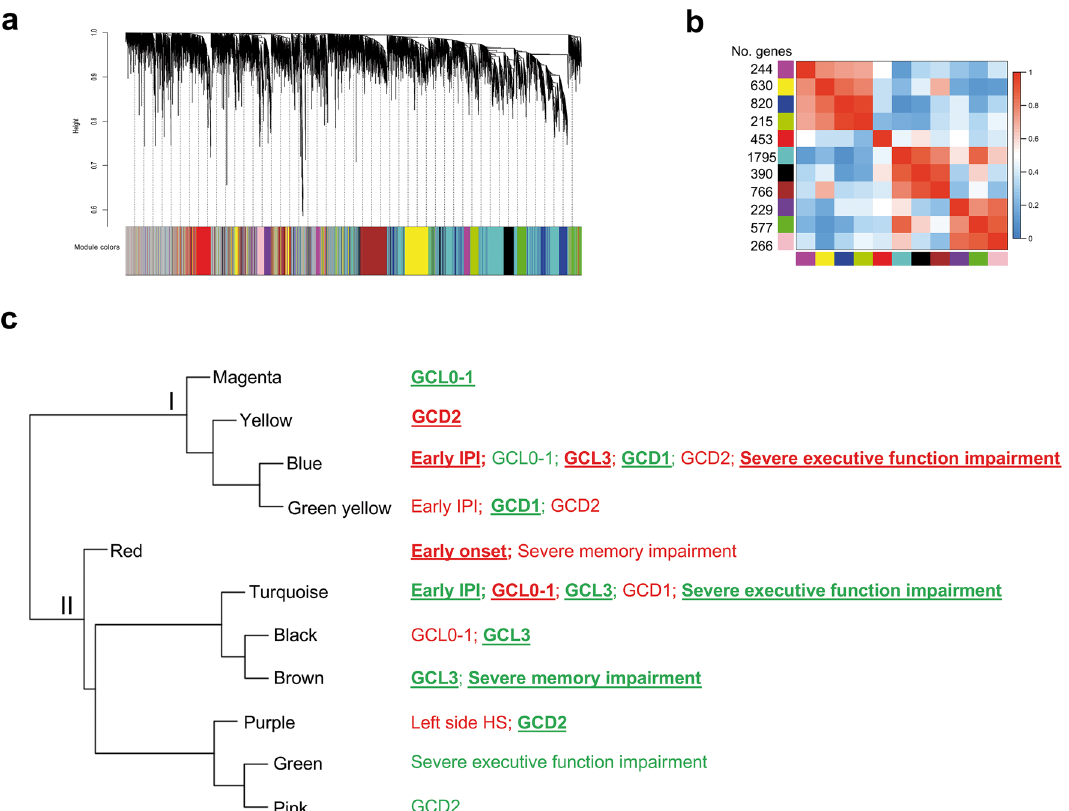
Figure 2. WGCNA analysis. Gene dendrogram and gene clustering analysis for module identification ( a ). Heatmap plot of the adjacencies in the eigengene network ( b ). Hierarchical clustering dendrogram of module eigengenes-evidencing the presence of two meta-modules (I and II)-and traits significantly correlated with modules ( c ). Positive or negative module-trait correlations depicted in red or green, respectively; the high module-trait correlations (r >|0.50|) are indicated by bold underlined letters. Network was constructed using the WGCNA package 24 (version 1.69-81) in R environment (version 3.4.4 93 ; https:// horva th. genet ics. ucla. edu/ html/ Coexp ressi onNet work/ Rpack ages/